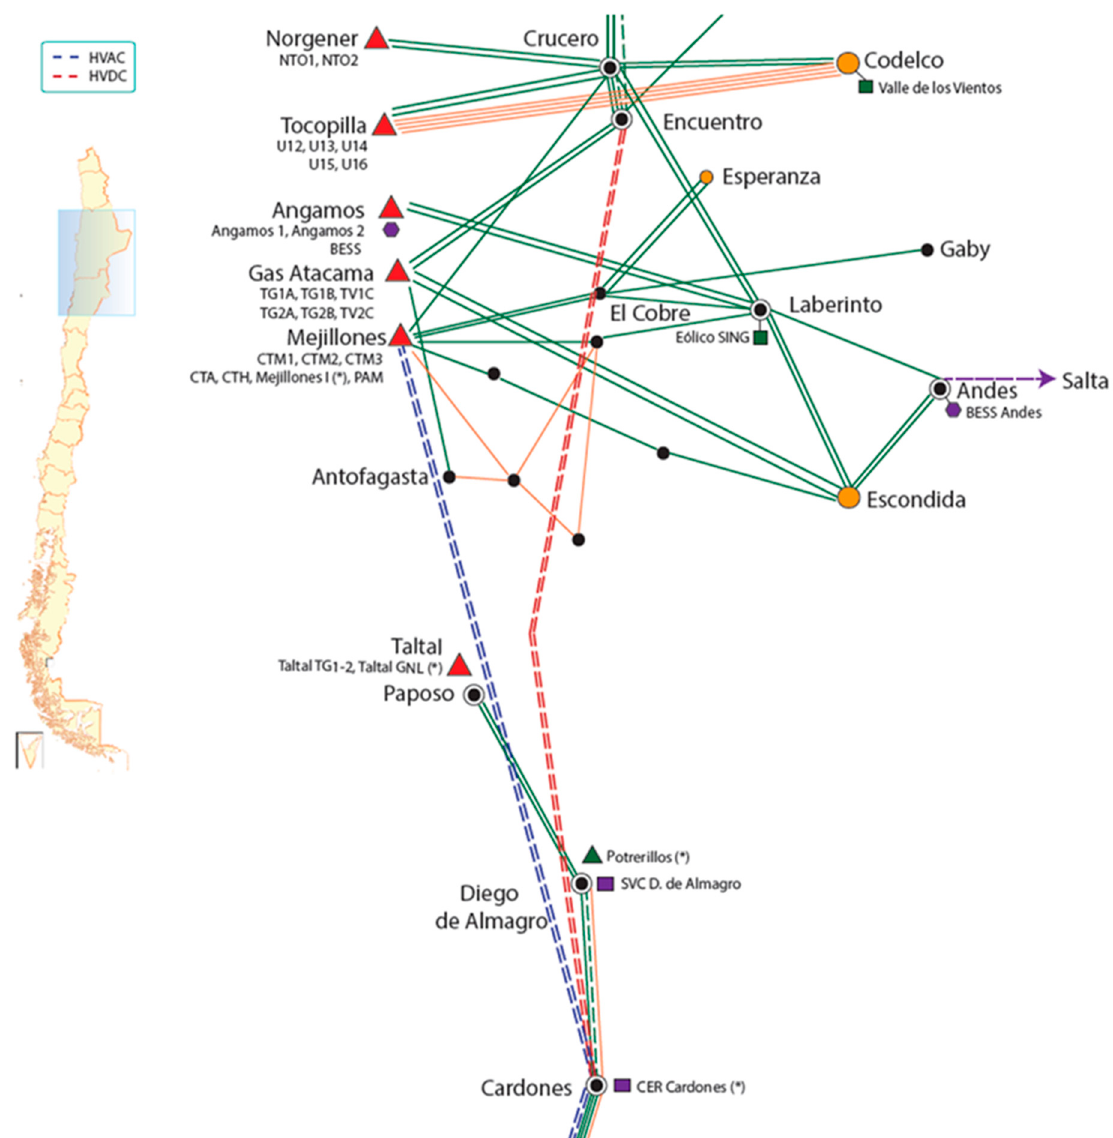
Figure 1. Map of Figure 1. Map of Interconnections.